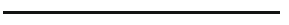
frequency of Fig. 4 for various anisotropy